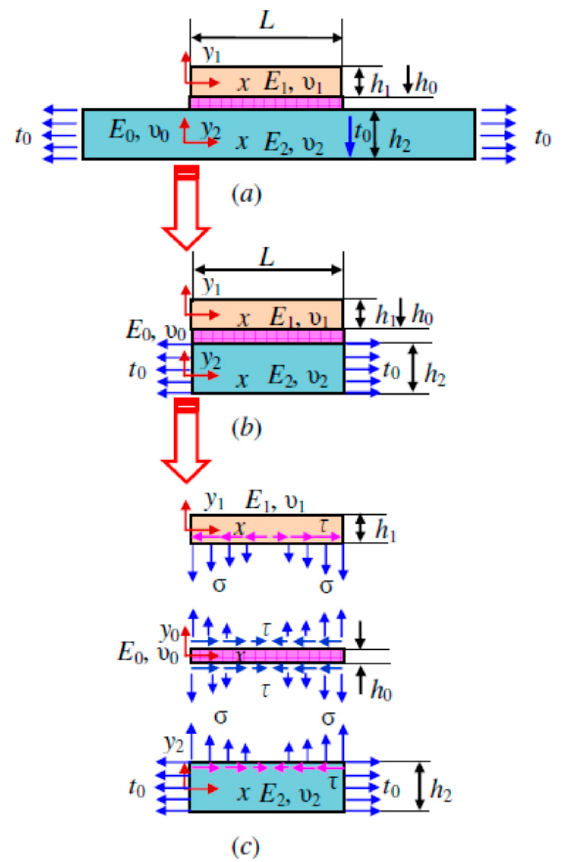
Figure 7. ( a ) Schematic of an adhesively single-sided joint (ASSJ) under uniaxial tension; ( b ) the slender upper adherend layer, the thin adhesive layer, and the slender lower adherend layer; ( c ) schematic interfacial stress distribution in the joint.